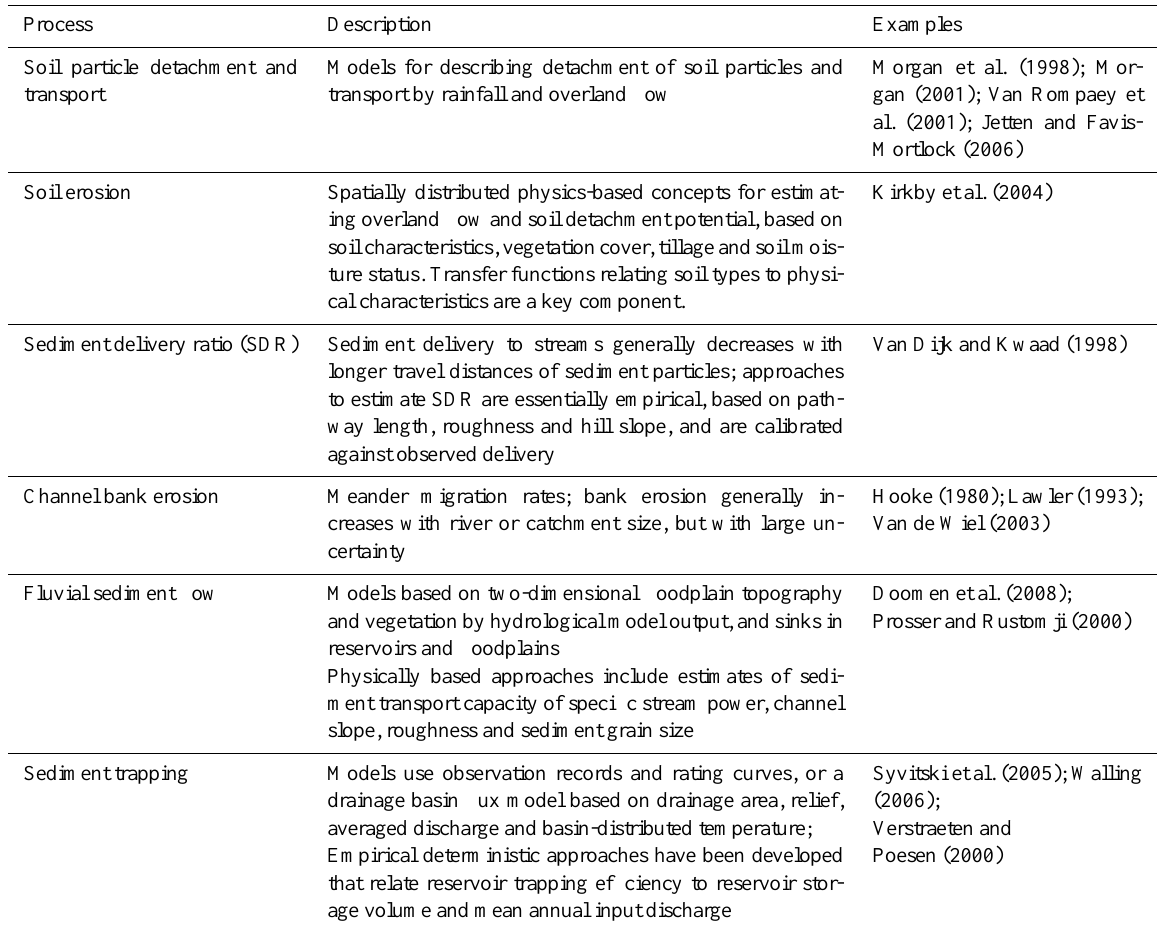
Table 5. Approaches for describing soil particle detachment, erosion, sediment delivery to streams, channel bank erosion, sediment transport in rivers and sediment trapping in